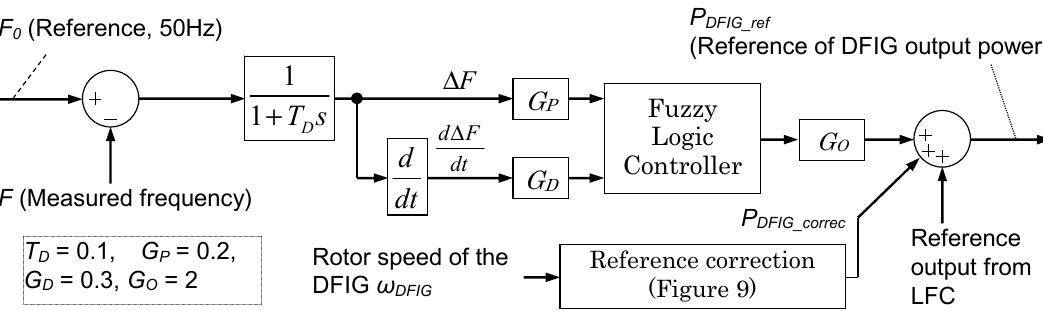
Figure 7. Active power controller of the DFIG as the ASG. Table 6. Fuzzy rules of the fuzzy logic controller of the DFIG.